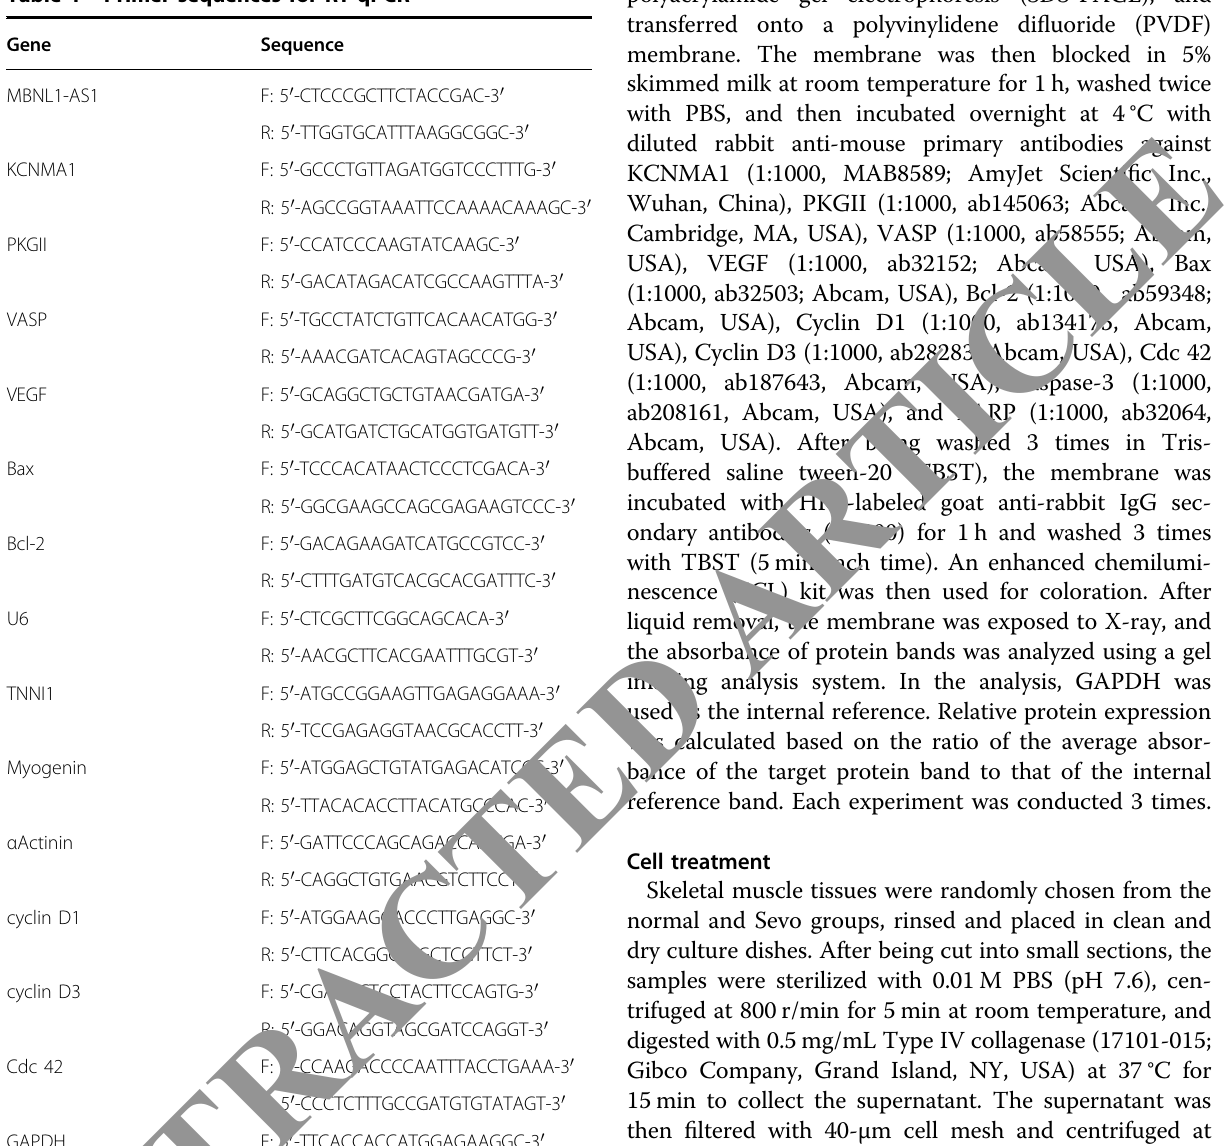
RT-qPCR reverse transcription quantitative polymerase chain reaction, MBNL1- AS1 muscleblind-like 1 antisense RNA 1, KCNMA1 potassium calcium-activated channel subfamily M alpha 1, PKGII type II cGMP-dependent protein kinase, VASP vasodilator-stimulated phosphoprotein, VEGF vascular endothelial growth factor, Bcl-2 B-cell lymphoma/leukemia-2, Bax Bcl-2 associated X protein, TNNI1 troponin I1, Cdc 42 cell division cycle 42, GAPDH glyceraldehyde-3-phosphate dehydrogenase, F forward, R